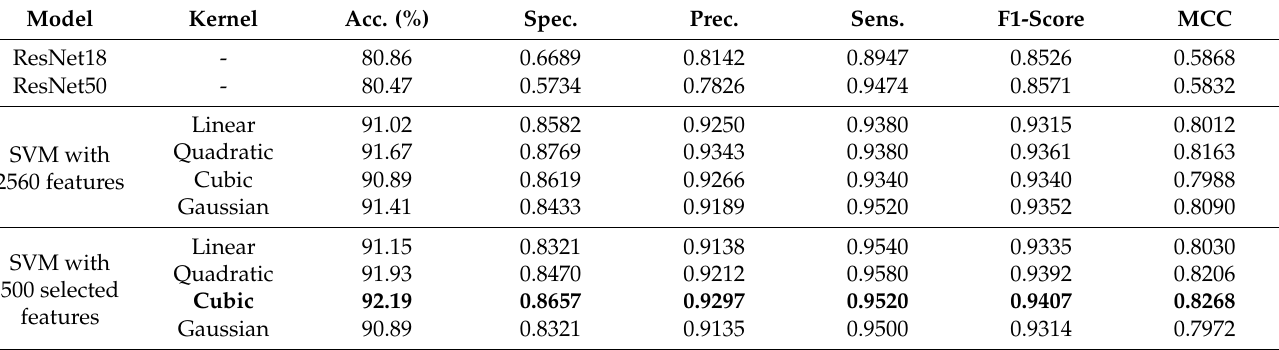
Table 4. Performance metrics for the three approaches.